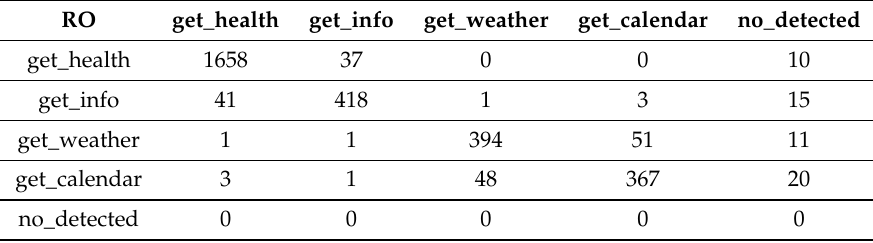
Table 5. Confusion matrix for the intent detection for the Romanian language.